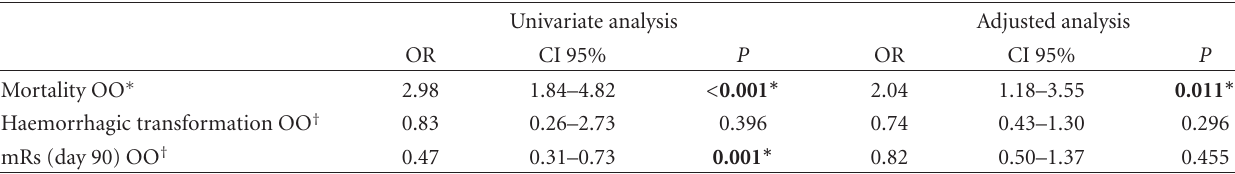
Table 3: Regression